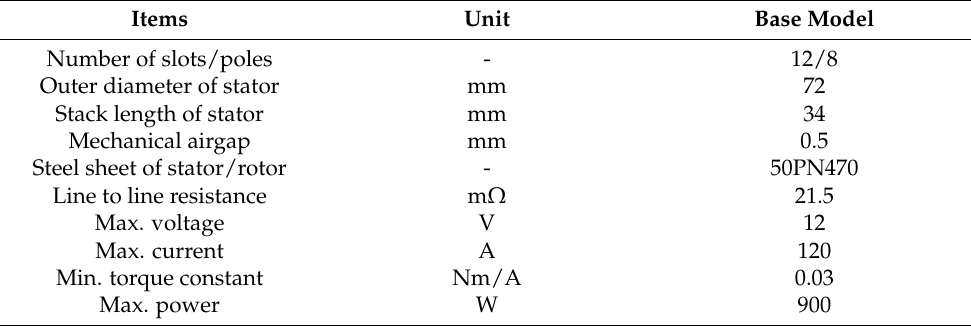
Table 1. Specification of the base model developed for integrated electric brake systems.